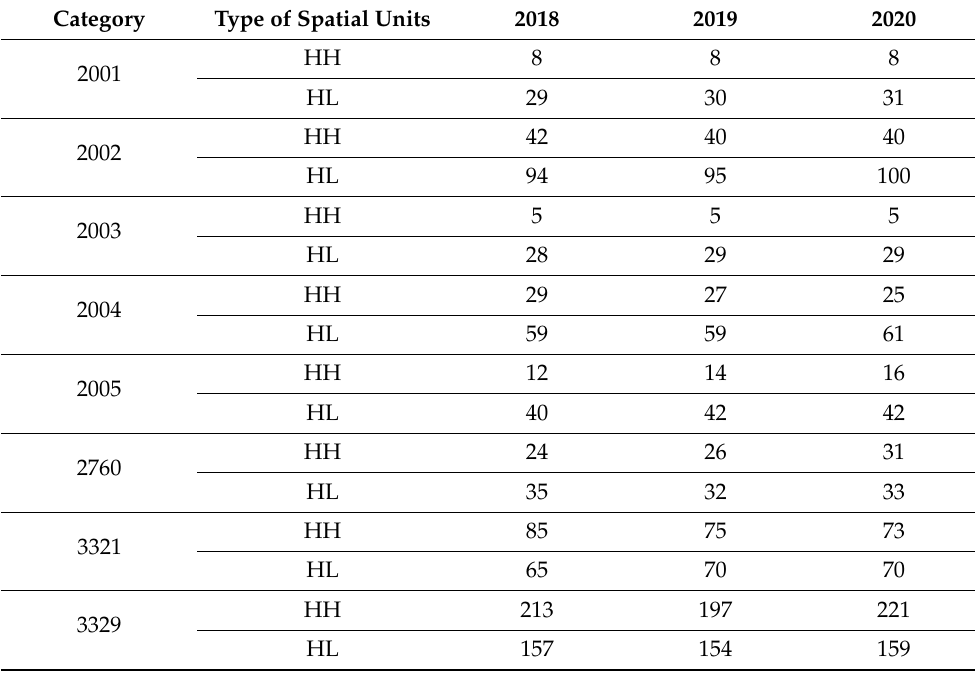
Table 4. LISA Analysis–COType Quantity Table.